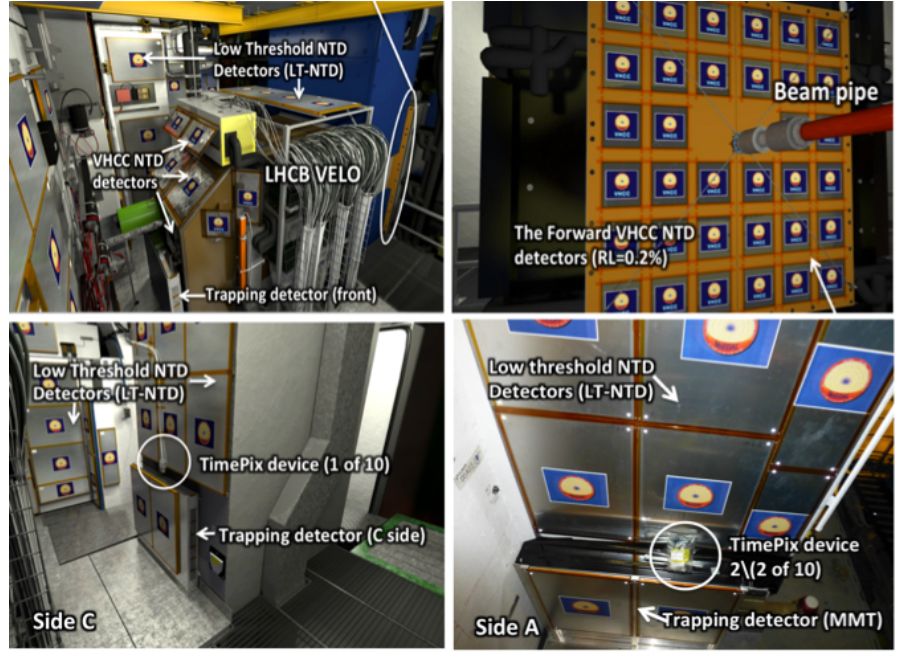
Figure 2. ( top left ) A view of part of the MoEDAL deployment showing the LHCb’s VELO detector as well as various elements of the MoEDAL detector; ( top right ) the 4sqm VHCC detector plane that is deployed in the downstream acceptance of the LHCb detector; ( botton left ) part of MoEDAL’s “C-side” deployment, including part of MoEDAL’s NTD array, one of three MMT detector stacks and one of five TMPX devices; and ( bottom right ) “A-side”